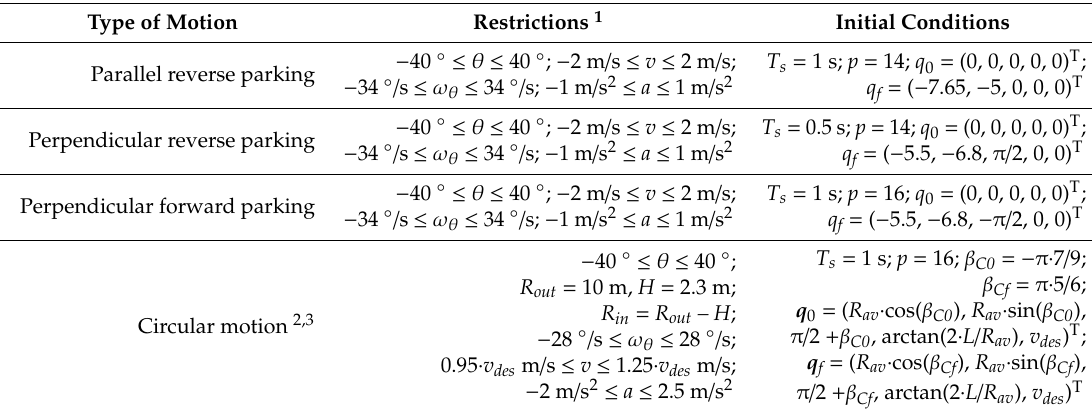
Table 1. Restrictions and initial conditions for simulating passenger